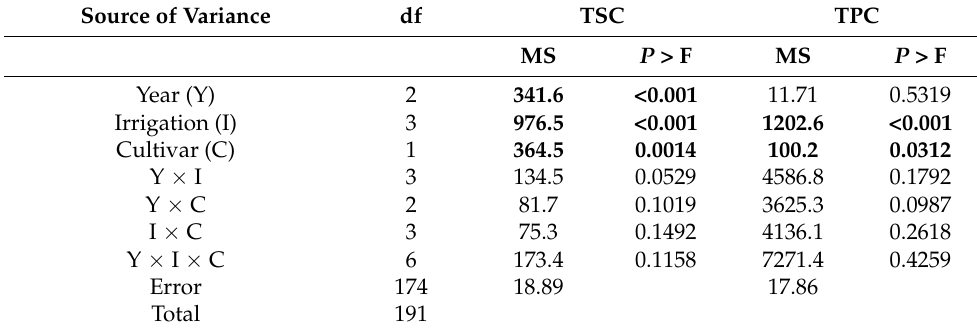
Table 7. Analyses of variance for the effects of year, deficit irrigation treatment, and cultivar on yield related measures of tree physiological properties (fruit set—FS, seasonal vegetative growth—SVG, fruit number per tree—FNT, fruit weight—FW, fruit yield—FY) in a commercial apricot orchard at Wadi El Natrun, Northern Egypt over 2016–2018 on two apricot cultivars ‘Ninfa’ and ‘Canino’. Explanations for bold figures are given in Table